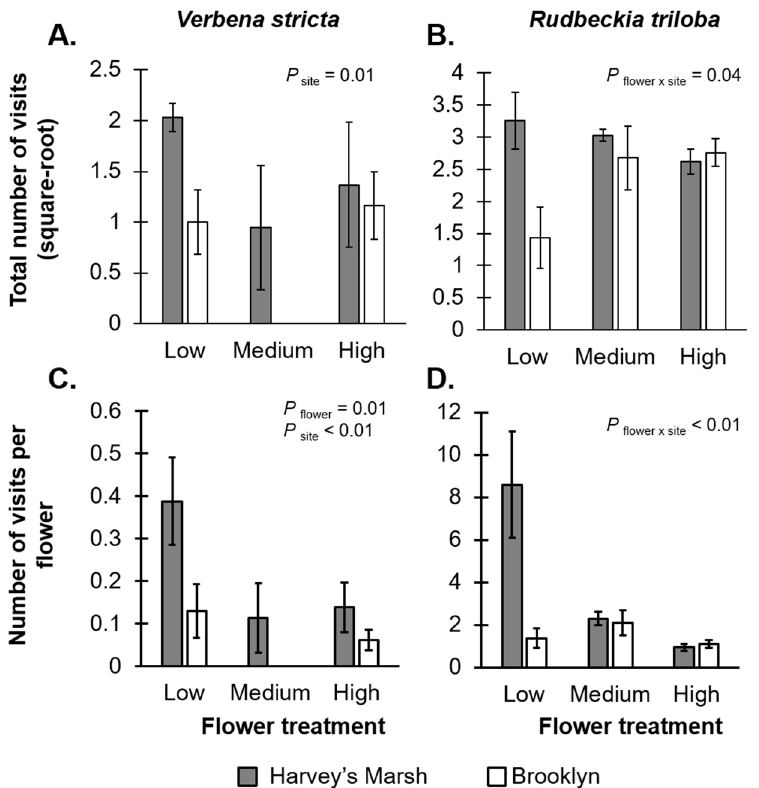
Figure 1. Flower treatment and site comparisons of Verbena stricta (left side) and Rudbeckia triloba (right side) on the total number of pollinator visits ( A , B ) and the number of visits per floral resource ( C , D ) within 30 min of observation. Grey bars represent rates at Harvey’s Marsh (a low resource density site); white bars represent rates at Brooklyn (a high resource density site). Error bars represent ±1 SE. The total number of pollinator visits was square-root transformed. Note: no visits occurred on V. stricta plants with a medium number of flowers at the high density site.